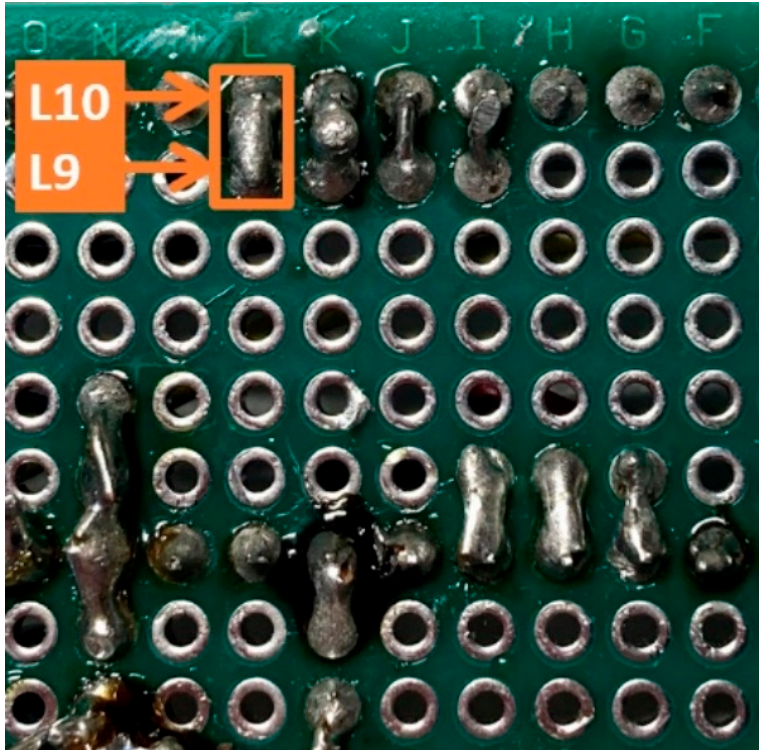
Figure A1. Illustration of wire solder labels. The top row is row 10, and it contained a row of header pins. A wire needed to connect to the header pin at L10. To do this, the wire was soldered into L9, then bent over onto L10 (which was already occupied by a header pin) and soldered in place. This wire would be labeled ‘L9:L10 ′ . First, the 15 × 1 female header pins were installed on row 10, columns A–O and row 4, columns A–O. These mount the Arduino Nano, with the USB port on the ‘A’ side. Next, the 2 × 1 header pins were installed in row 1, L-M. These headers receive the thermistor’s pre-installed connector.